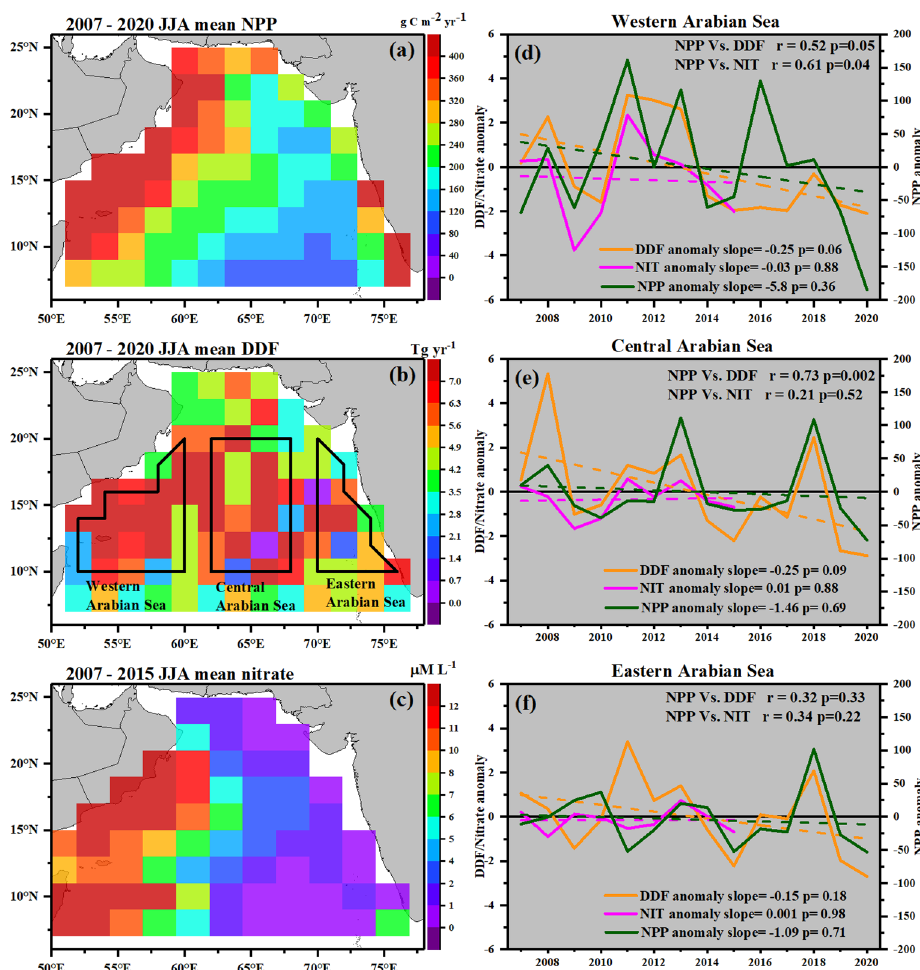
Figure 4. Spatial distribution of mean (a) NPP, (b) DDF, and (c) nitrate (NIT) during JJA. The geographical separation of the Arabian Sea region is based on dust deposition and is shown in (b) . The interannual trends of the NPP, DDF and NIT anomalies over the (d) western Arabian Sea, (e) central Arabian Sea and (f) eastern Arabian Sea. The interannual trends are estimated using linear regression, and their significance is tested using the Mann-Kendell test, and those statistics are shown at the bottom of each plot ( d–f ). The dependency of NPP on the DDF and NIT is shown using the correlation analysis. The Pearson’s r values and p -values of each relating variable are shown on top of each plot ( d–f ). Note that the availability of NIT data from NOBM is only till 2015; the spatial distribution of mean NIT during JJA is calculated from 2007 to 2015.